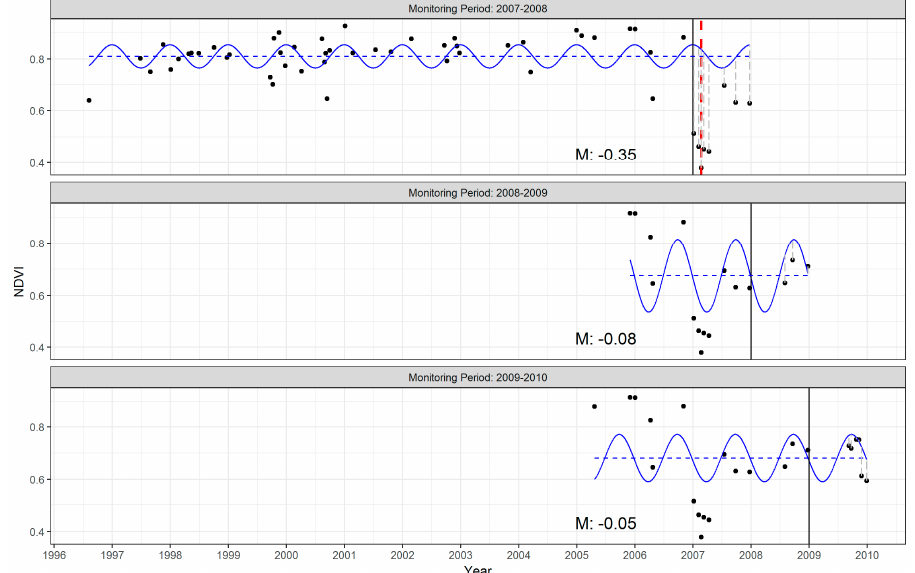
Figure 3. Example of pixel-level BFAST Monitor output using a 2007–2010 subset of the Landsat time series. Black solid lines denote the beginning of the monitoring period, black dots are observed NDVI observations, blue lines denote expected values from the fitted seasonal model, and grey dashed lines represent the residuals in each monitoring period. A breakpoint (dashed red line) is identified in early 2007 with a magnitude (M) of − 0.35 but is not detected in 2008 or 2009. The historical periods for 2008–2009 and 2009–2010 are shorter than the 2007–2008 period because BFAST Monitor only includes preceding observations until the stable seasonal model breaks down.